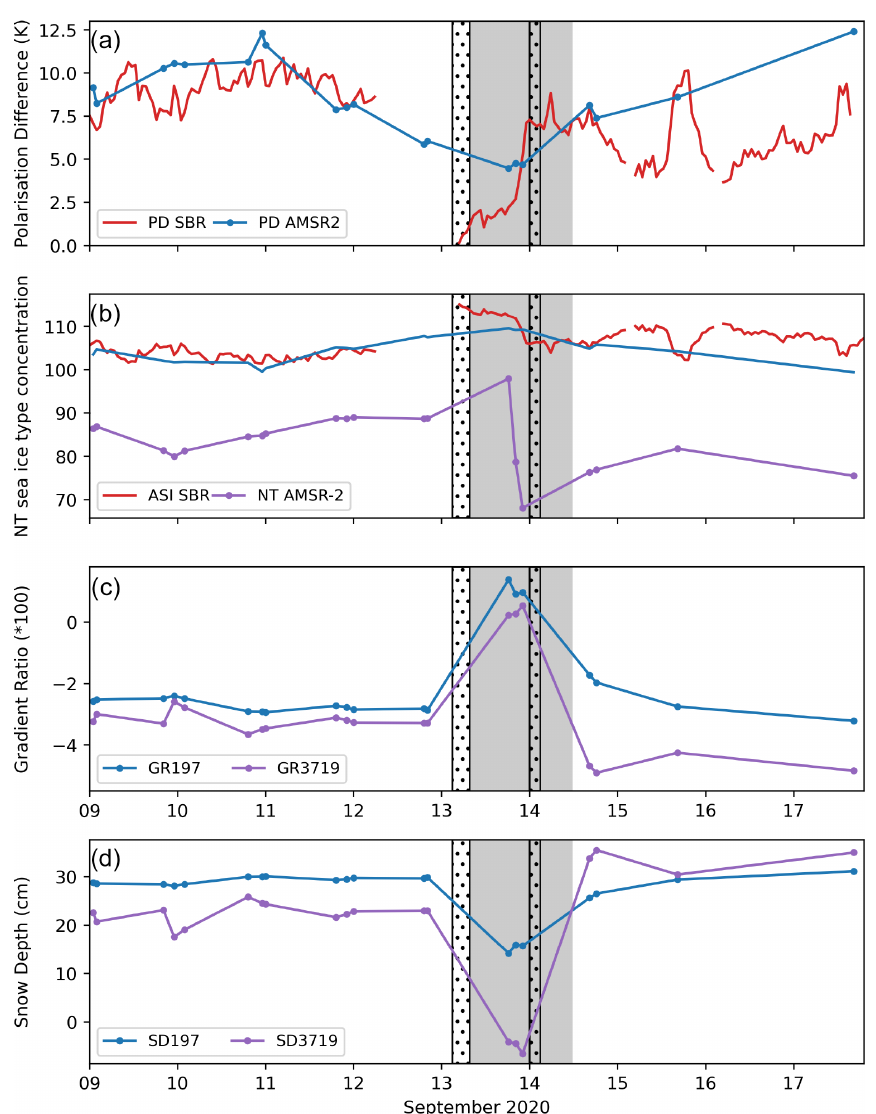
Figure 10. (a) Collocated AMSR2 and SBR polarization difference (PD) at 89GHz (top) and (b) sea ice concentration derived from the polarization difference at 89GHz using the ASI algorithm (Spreen et al., 2008). In addition, the sea ice concentration from the NASA Team algorithm (Cavalieri et al., 1999) is shown. (c) Gradient ratio (at vertical polarization) derived from AMSR2 37 and 19GHz (blue) and 19 and 7GHz (red) observations and (d) snow depth derived from GR19 / 7 and GR37 / 19 during the ROS